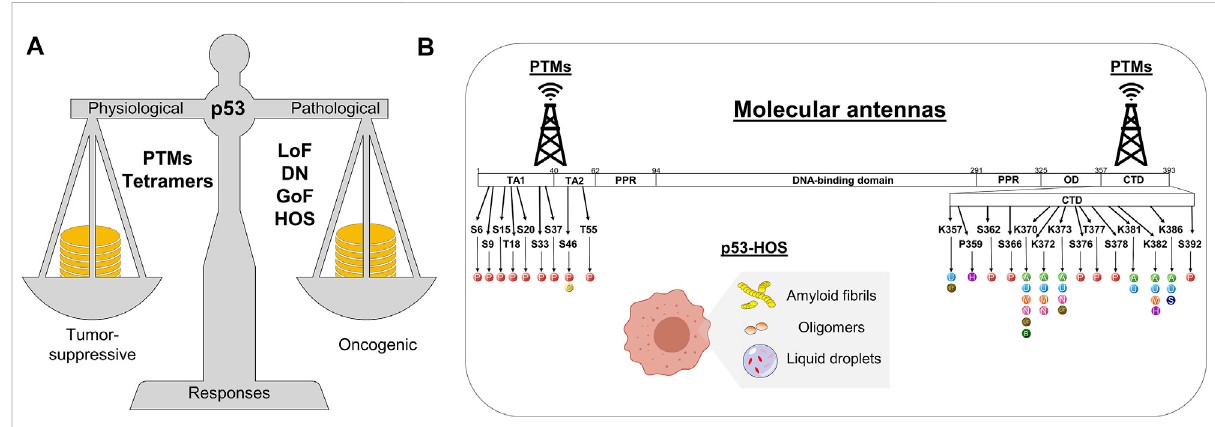
FIGURE 2 Schematics showing (A) the p53 balancing in heath and disease and (B) two mechanisms in which p53 is stabilized to execute transcriptional programs or gain-of-function activities. Residues that undergo post-translational modi fi cations at the NTD and CTD are highlighted with their respective possible modi fi cation indicated as: P, Phosphorylation; C, Crotonylation; U, Ubiquitination; UF, UFMylation; H, Hydroxylation; A, Acetylation; M, Methylation; N, NEDDylation; B, β -hydroxybutyrylation; S, SUMOylation. PTMs, post-translational modi fi cations; LoF, loss-of- function; DN, dominant negative; GoF, gain-of-function; HOS, higher-order structure; TA, transactivation domain; PPR, proline-rich motif; OD, oligomerization domain; CTD, C-terminal